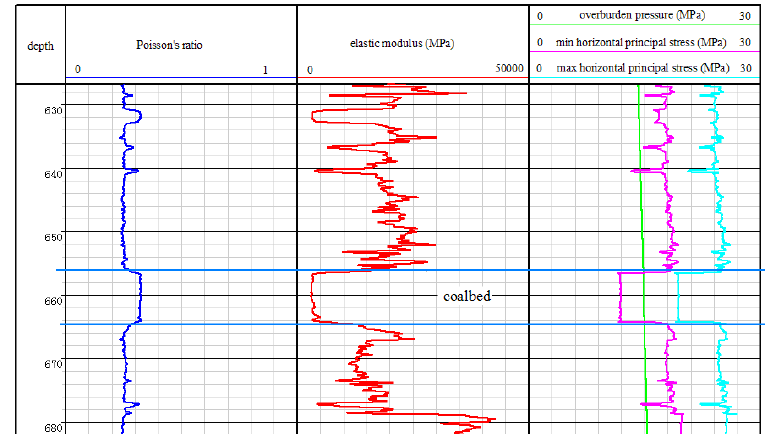
Figure 5. The interpretation data of rock mechanics parameters. Table 2. The calculation results of fracture